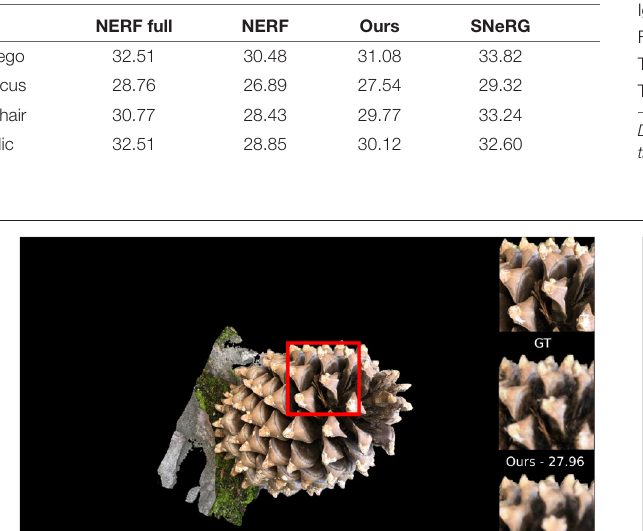
Frontiers in Computer Science |